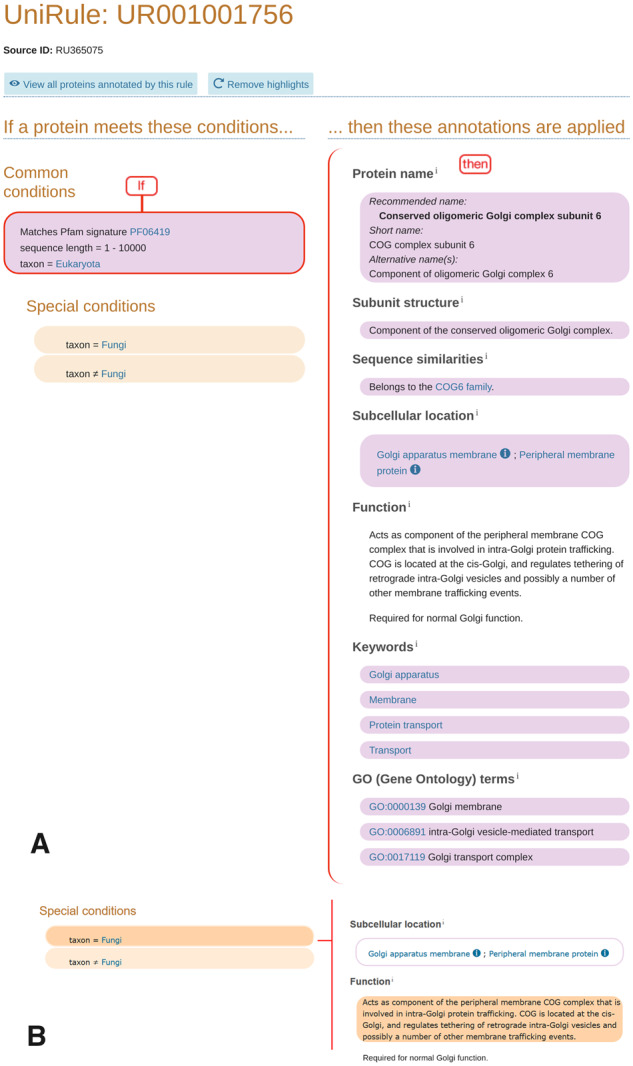
An example UniRule rule as displayed on the UniProt website. (A) UniRule display after the common conditions are selected (highlighted in lilac), showing the annotations (highlighted in lilac) that are applied to records meeting the conditions. (B) Part of the UniRule display after the first special condition, ‘taxon = Fungi’ is selected. The condition is highlighted in brown and the annotation that is added when this condition is met is also in brown. (https://www.uniprot.org/unirule/UR001001756)